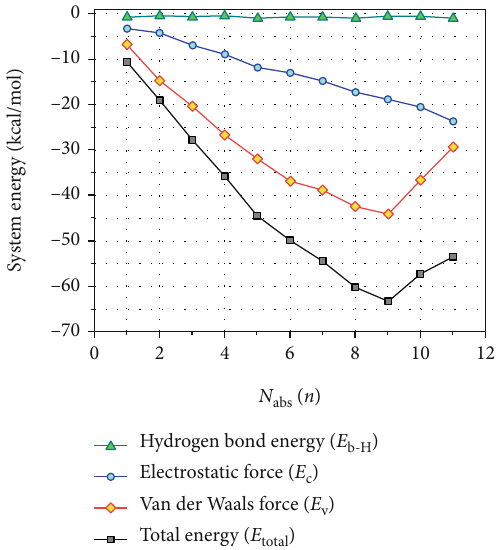
Figure 6: Energy changes during unit cell adsorption of di ff erent amounts of CH molecules. 4